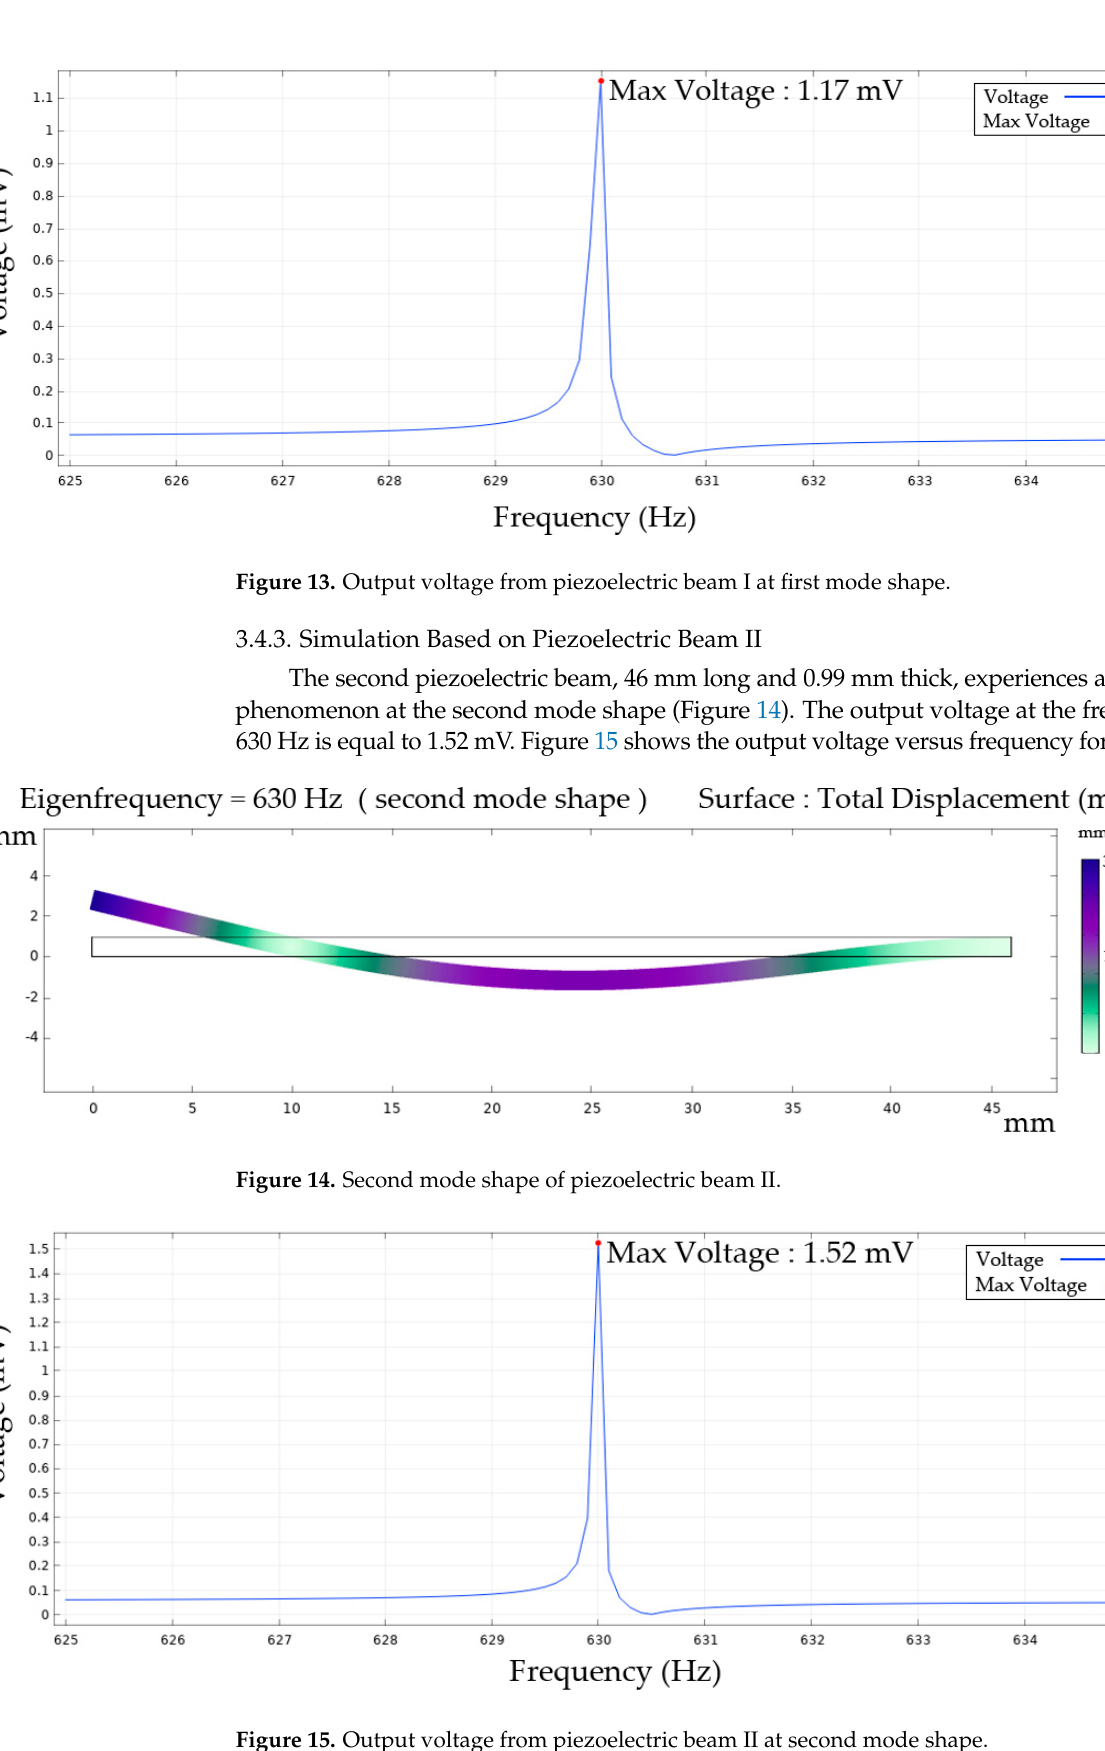
Figure 12. First mode shape of piezoelectric beam I.